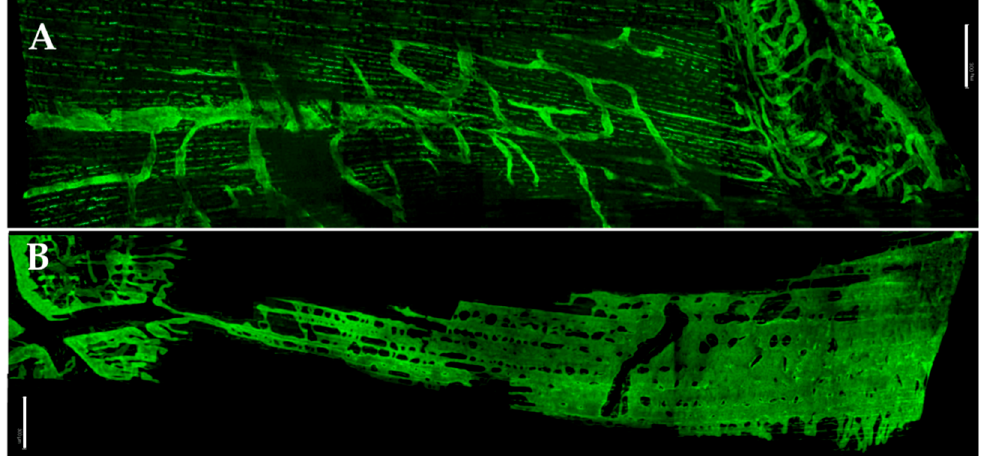
Figure 2. Confocal images of LYVE 1 stained mouse submesothelial lymphatic lacunae over the pleural (Panel ( A )) and peritoneal (Panel ( B )) sides of the diaphragm. A complex mesh of lymphatic vessels formed by confluent loops, linear vessels of variable sides equipped with lymphangions and thinner interfibrillar vessels are visible only in the pleural lymphatic side ( A ). On the peritoneal side, lymphatics are instead organized in large, flattened lacy-ladder shaped membranous structures (LLS). Bars: 300 µm.